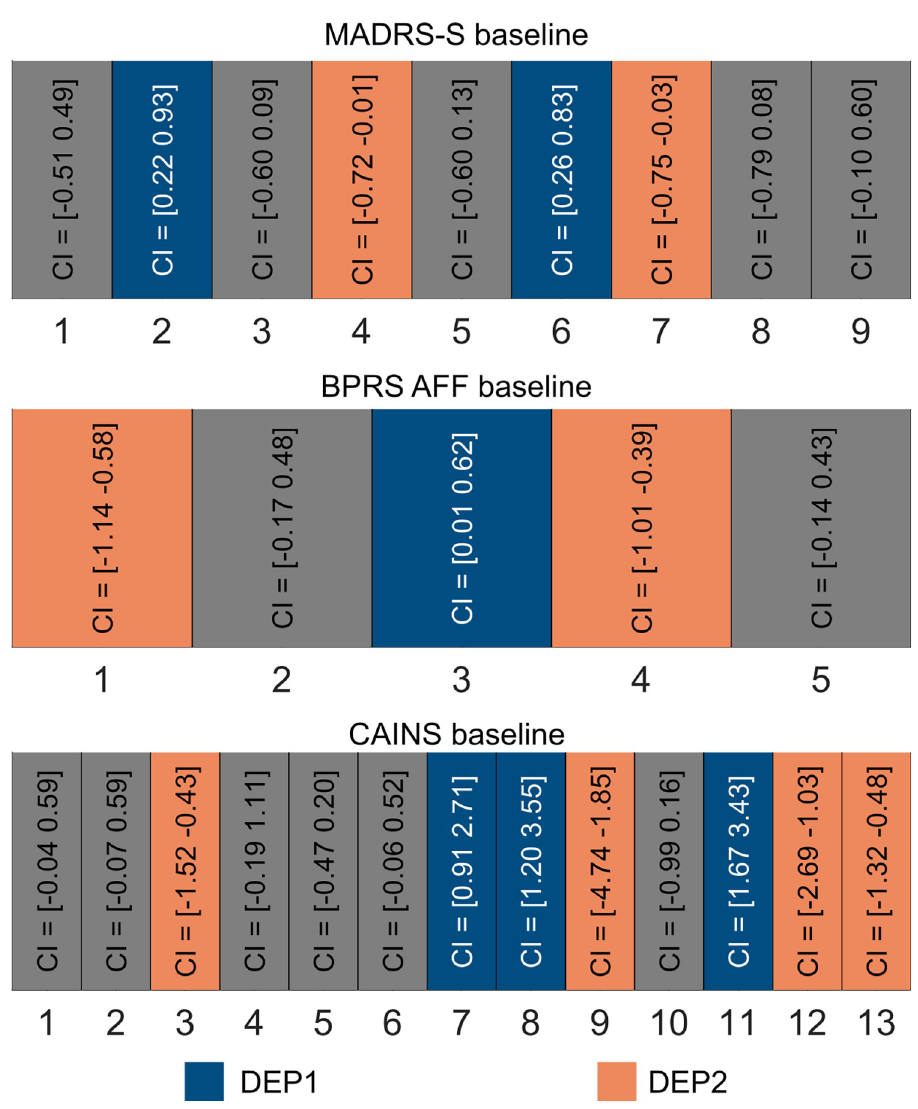
Fig 2. Specific symptoms of MADRS-S, BPRS AFF and CAINS predict depression subtypes at baseline. The bootstrap 95% confidence intervals of the logistic regression coefficients for MADRS-S, BPRS AFF and CAINS at baseline. The numbers on the horizontal axes of each panel correspond to the symptoms listed in Treatment section for a given symptom rating. The blue and orange colors indicate the individual items that were significantly different for a specific depression